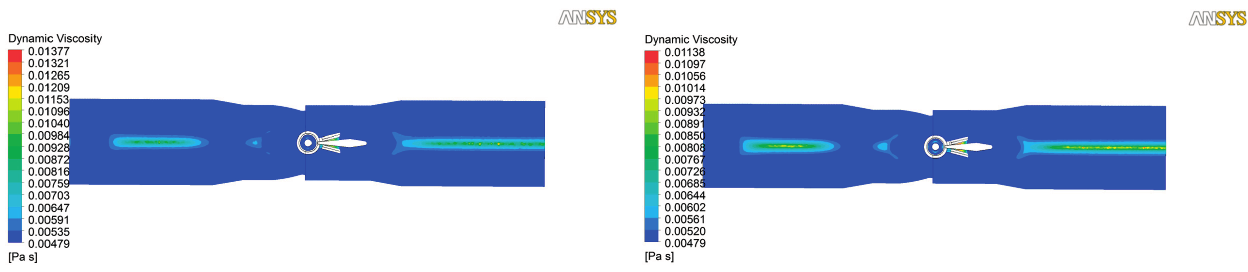
Figure 6. Streamlines of the dynamic viscosity on the symmetry plane of the valve. ( a ) the CAD valve design; ( b ) the fabricated